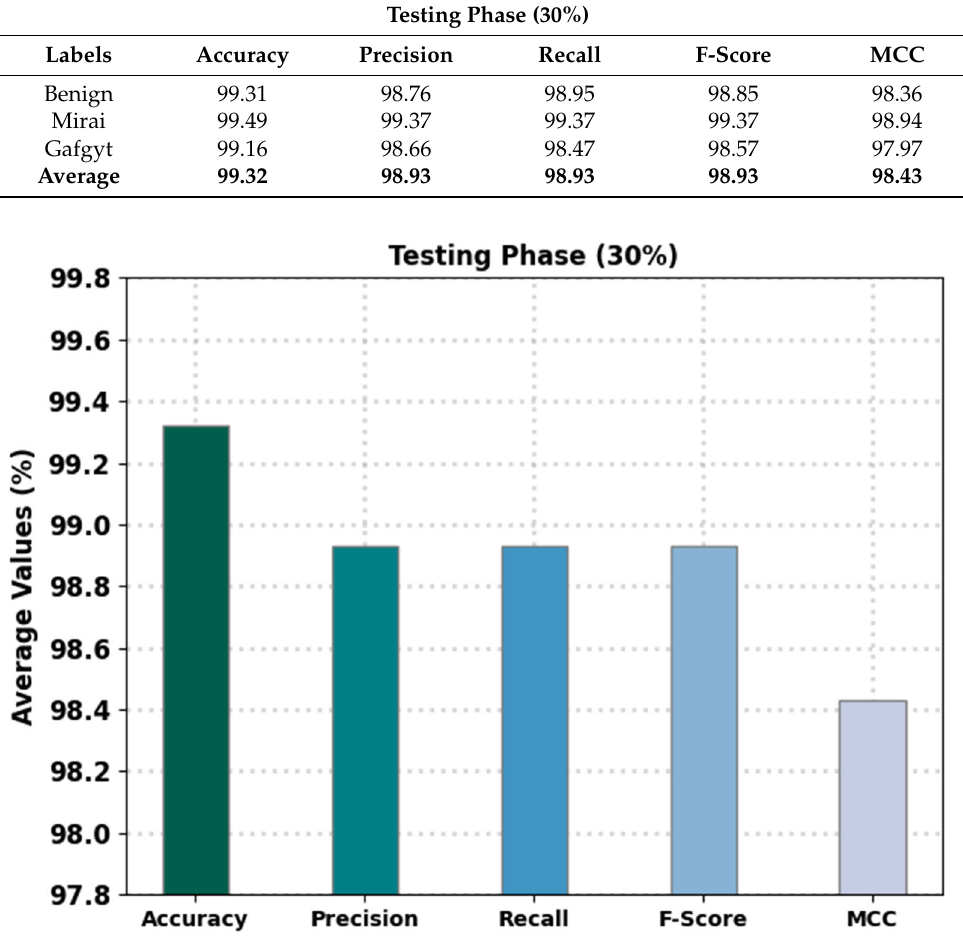
Figure 6. Average analysis for BND-BMOML algorithm using 30% of the TS data.